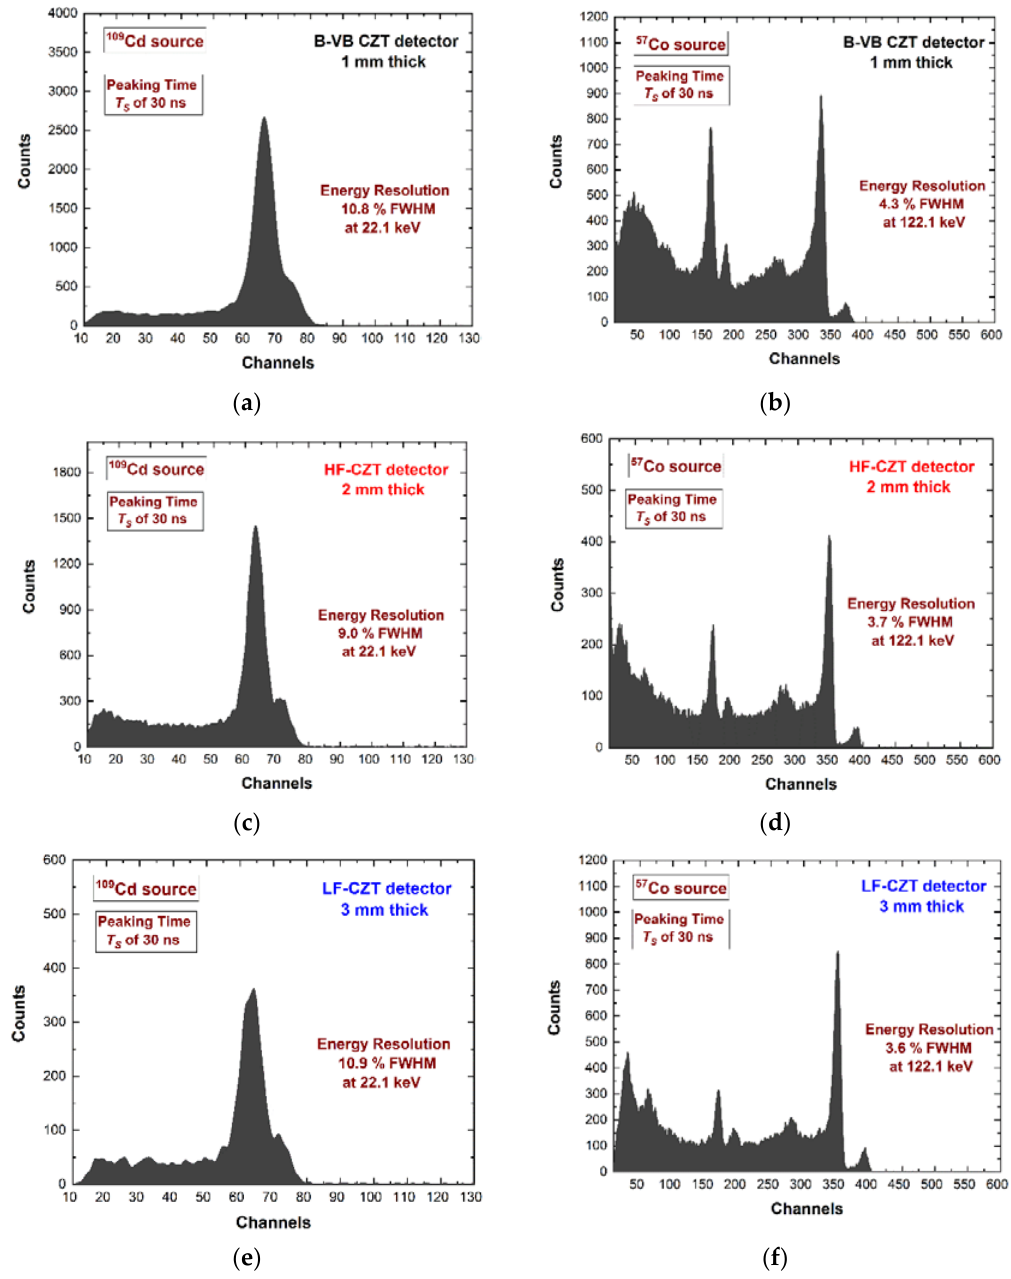
Figure 7. Measured ( a , c , e ) 109 Cd and ( b , d , f ) 57 Co energy spectra for the three CZT pixel detectors. All spectra were obtained using the ballistic deficit pulse processing with a peaking time T S of 30 ns (dead time of 90